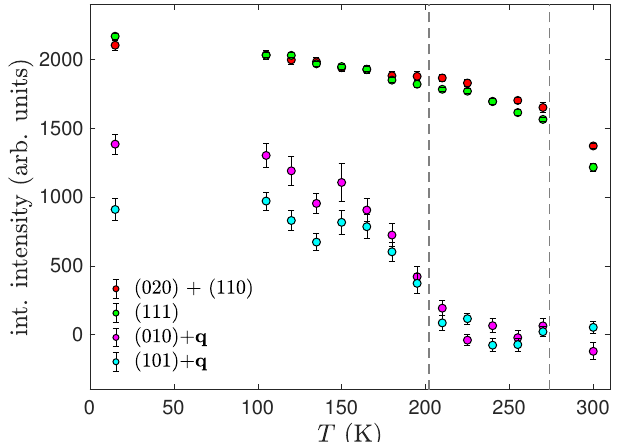
Figure 6: Integrated intensities of selected Bragg reflections at positions with integer and non-integer Miller indices, the latter being moduated by the propagation vector q = ( 1 / 3 0 0). The (020) and (110) reflections cannot be separated due to their very similar scattering angle (2 θ = 26.7 ◦ and 26.8 ◦ , respectively), but both reveal a signif- icant magnetic contribution which results in a comparable temperature dependence as the single peak (111) at 2 θ = 30.4 ◦ . The magnetic satellites show an increase in intensity upon cooling below approximately 200 K. The transition temperatures derived from the single-crystal experiments (cf. Fig. 3) are shown as vertical dashed